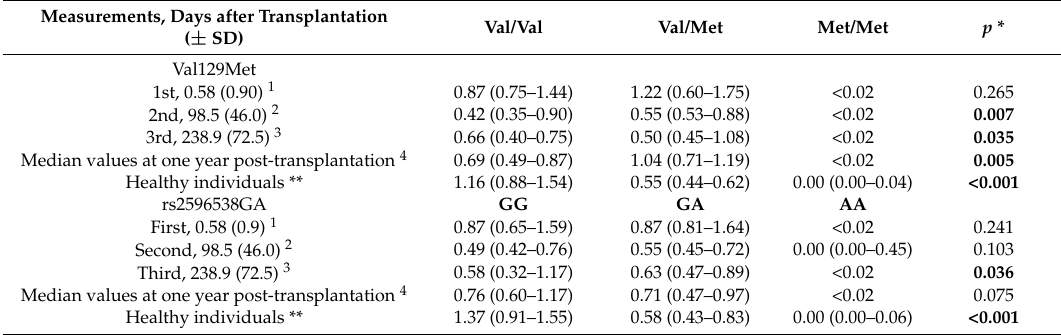
sMICA values are presented as medians (25%–75%). Bold values indicate statistically significant effects. 1 First measurement: Val129Met Val/Val ( n = 6), Val/Met ( n = 6), and Met/Met ( n = 1); rs2596528 GG ( n = 7), GA ( n =